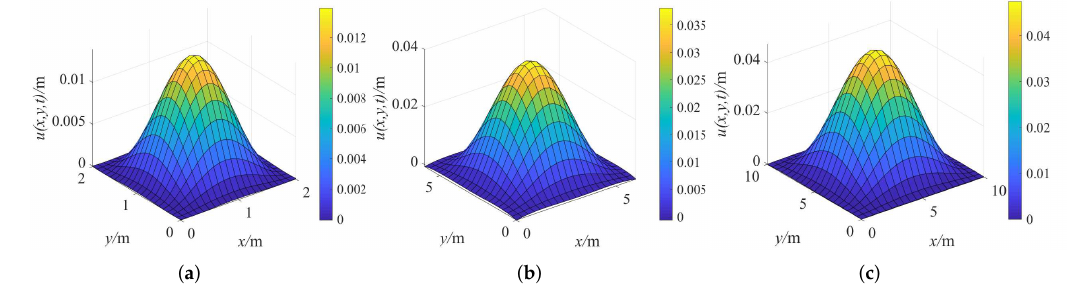
Figure 4. Displacements under external load F = 0.08sin ( 0.01 t ) at different side lengths for ( a ) a × b = 2m × 2m. ( b ) a × b = 6m × 6m. ( c ) a × b = 10m ×